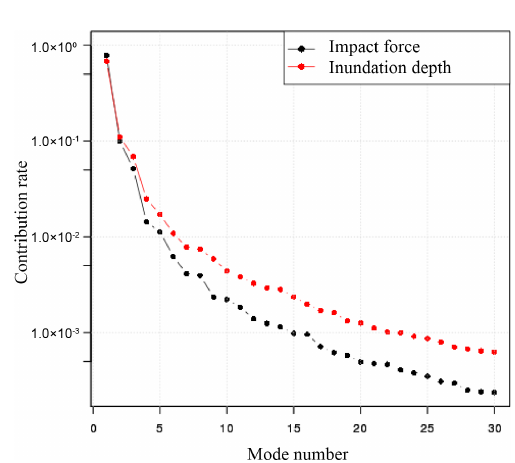
Figure 12. Contribution rate for each risk